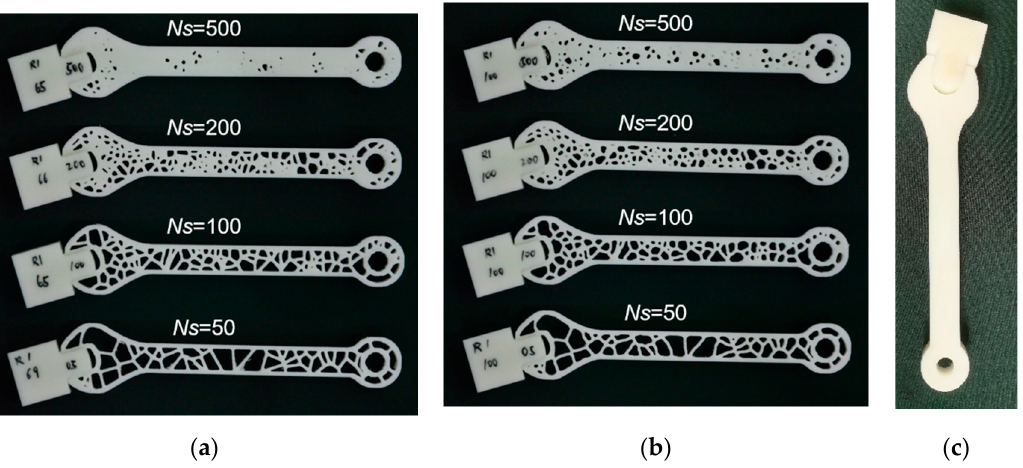
Figure 3. Cellular wrenches generated using Voronoi–Monte Carlo approach and manufactured using stereolithography for an increasing number of seed points N S and as a function of the relaxation time t R ( a ) 71 MCS, ( b ) 100 MCS, ( c ) fully solid wrench used as a control group.